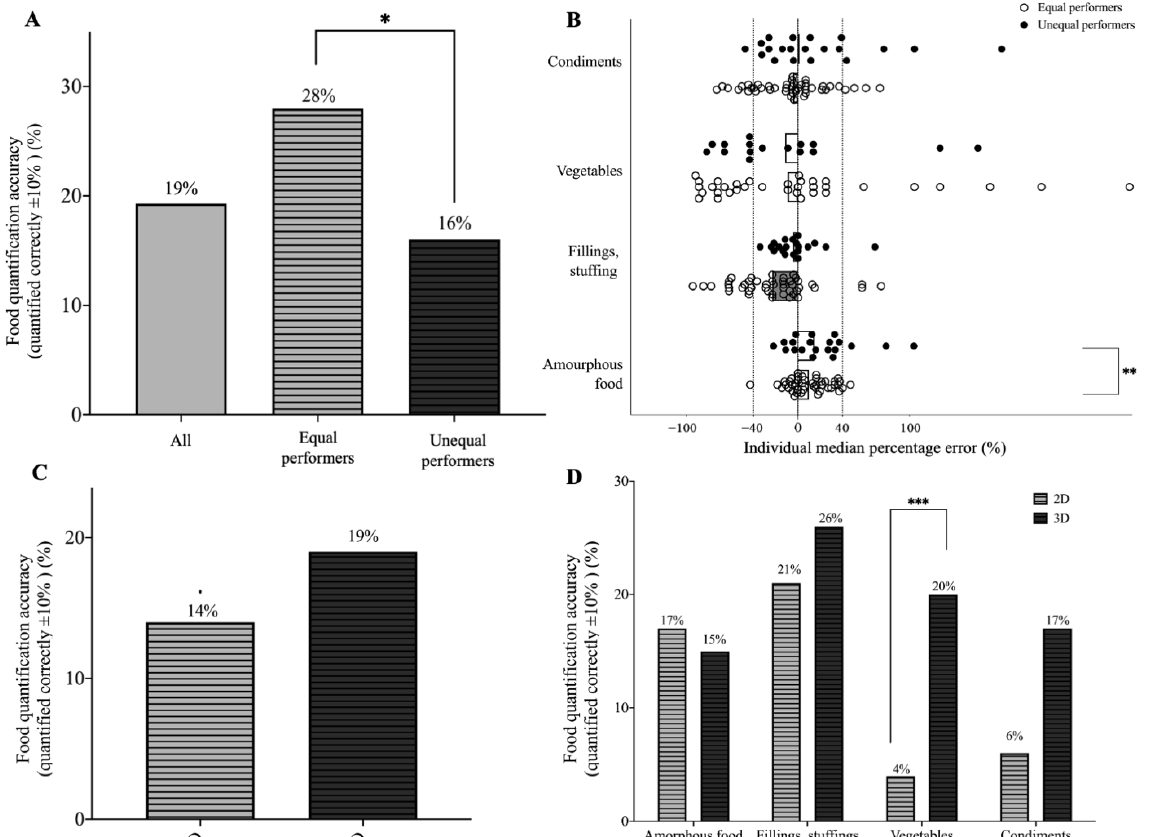
Figure 3. Accuracy of food quantification ( A ) and median percentage error ( B ) of estimated calories between equal ( n = 45) and unequal ( n = 20) performers in the first semester. Overall food quantification accuracies (within ±10% difference of total calories) ( C ) and stratified by food groups ( D ) between the 2-D and 3-D food models among unequal performers. Equal and unequal performers were defined using their performance difference between 2-D and 3-D estimates of <6 or ≥ 6 out of 12 tested food items, respectively, in the first semester. * p < 0.05; *** p < 0.001 .